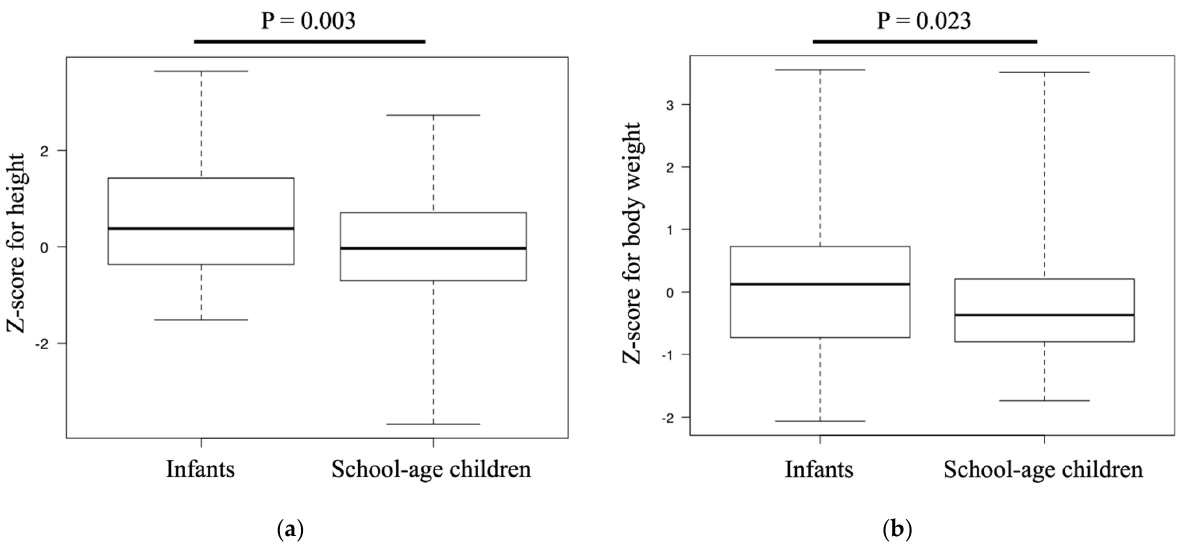
Figure 1. Comparison of Z-scores between the infant and school-age groups: (a) Z-score for height and (b) Z-score for body weight. The box plots show the interquartile range as well as the maximum and minimum values.